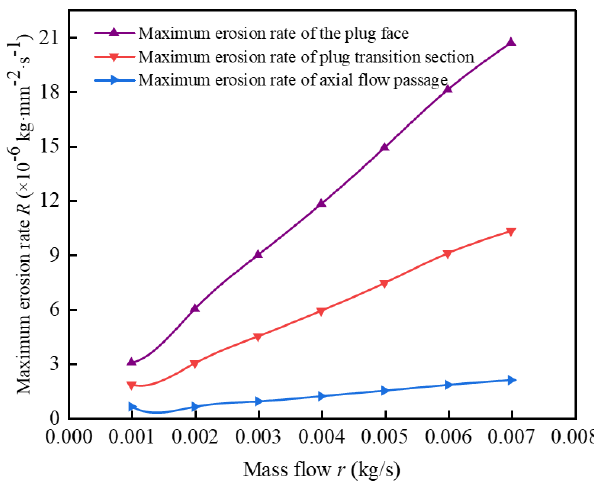
Figure 7. The maximum erosion rate changes with mass flow.